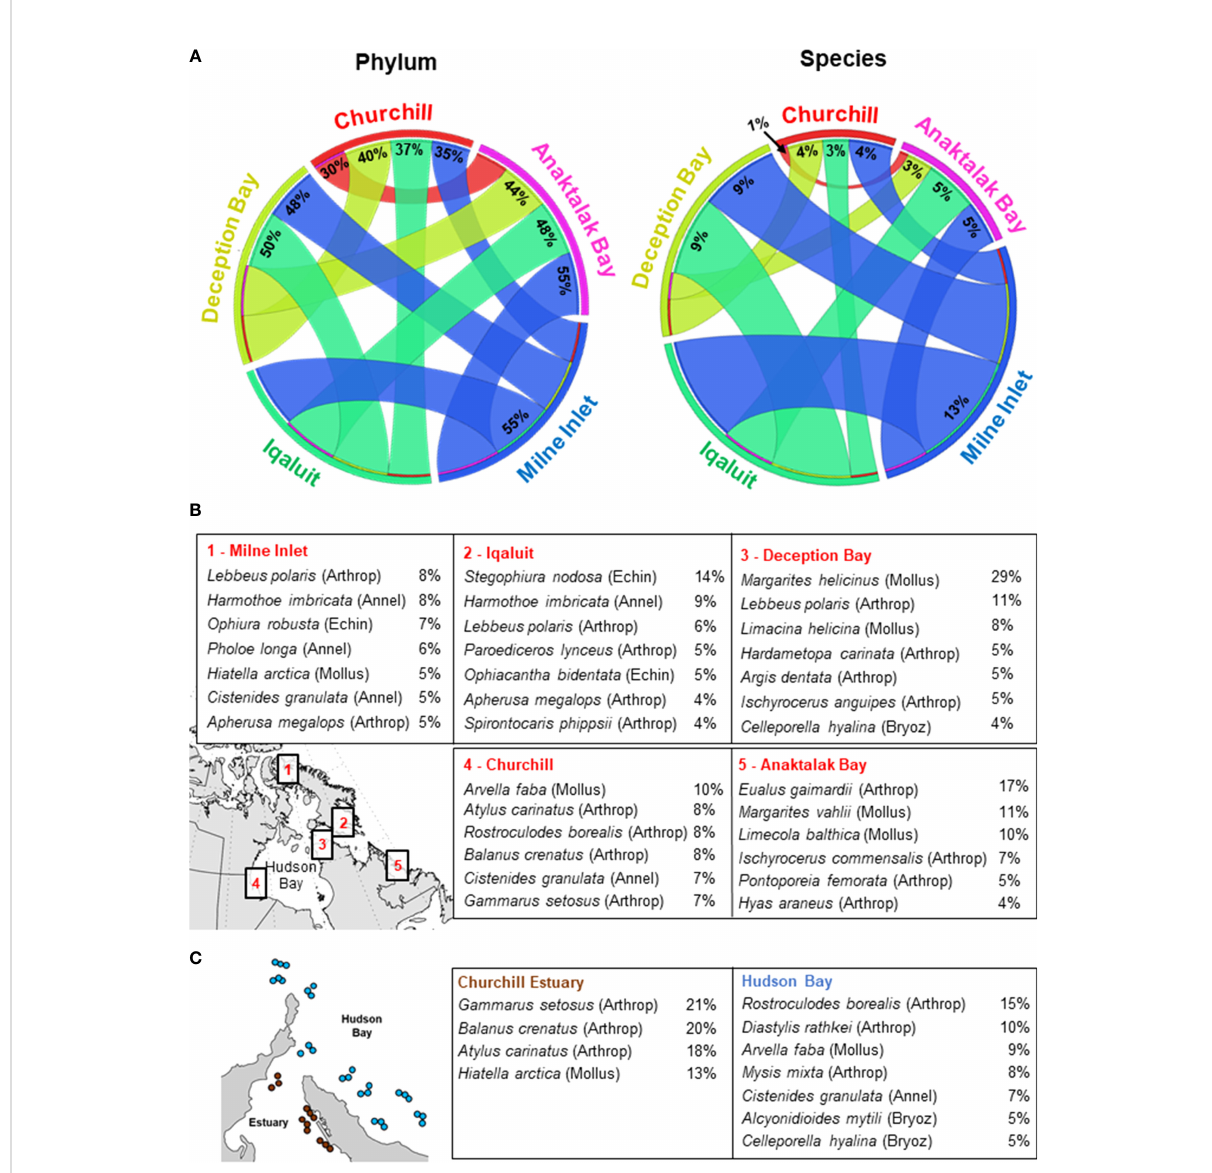
FIGURE 4 Similarity (%) of benthic assemblages among Arctic locations. (A) Circos plots showing similarities in assemblage composition among Arctic locations at the phylum and species levels. Values range from 0 (complete dissimilarity) to 100% (complete similarity) and are represented by the width of the lines between locations. Contribution of each species to the overall assemblage composition of (B) each Arctic location and (C) between Churchill Estuary and Hudson Bay based on SIMPER analyses. Phyla are shown in parenthesis as Arthrop, Arthropoda; Mollus, Mollusca; Annel, Annelida; Bryoz, Bryozoa; Echin,